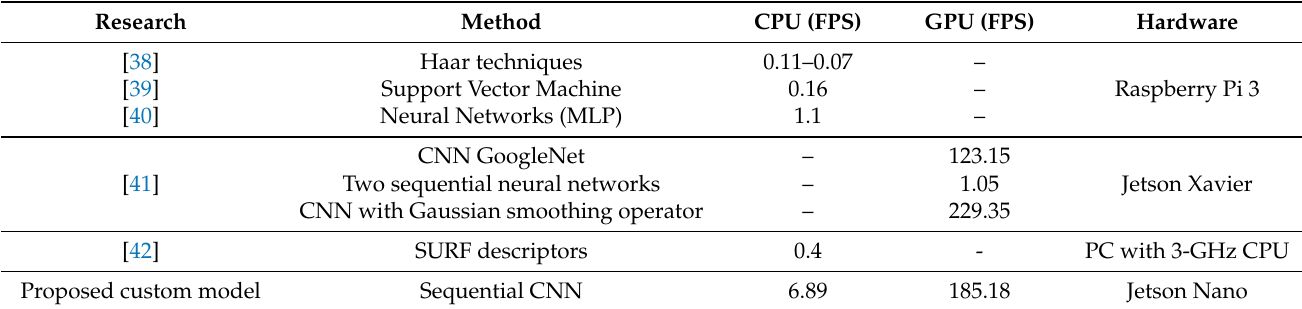
Table 4. Comparison of the proposed model with similar systems in the